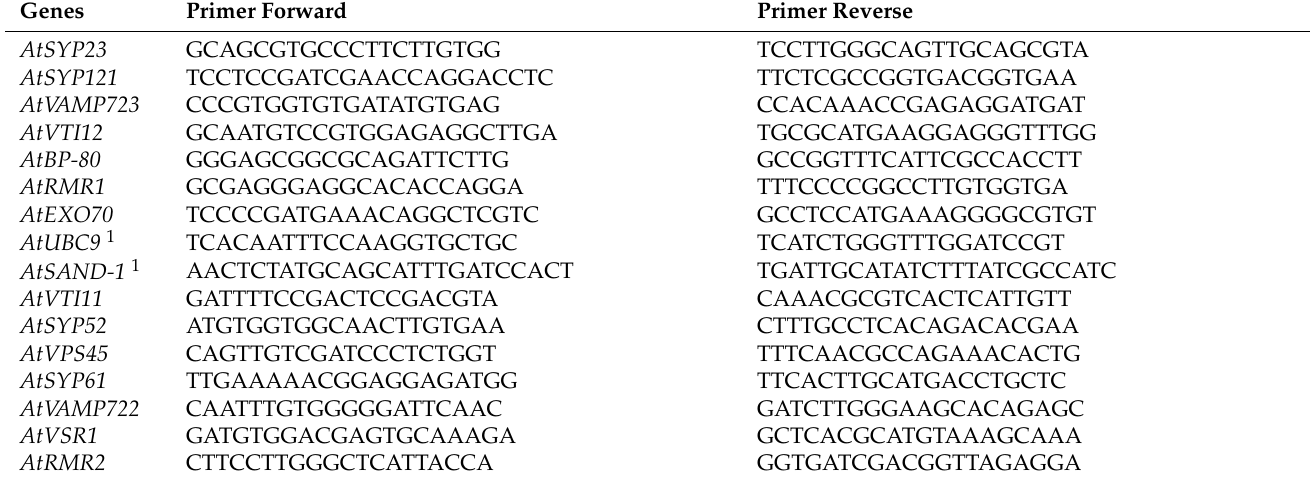
denaturation (95 ◦ C for 3 min), followed by 40 cycles of amplification and quantification (95 ◦ C for 10 s, 56 ◦ C for 10 s and 72 ◦ C for 30 s with a single fluorescence measurement) and melting curve generation (65 ◦ C to 95 ◦ C with one fluorescence read every 0.5 ◦ C). Calculation of cycle threshold (Ct), primer efficiency and expression tests were performed using Bio-Rad CFX Maestro (version 1.0) software. The analysis of the results obtained was carried out by comparison with the control condition. The housekeeping genes SAND-1 and UBC9 were used as reference genes, based on the study of Czechowski and collaborators [58]. The gene clustering by average linkage and heat map was obtained using the online software Heatmapper (http://www.heatmapper.ca/, accessed on 3 August 2021), applying the Pearson correlation between the normalized expression of the different genes and the stress conditions [59]. Table 3. List of genes and corresponding primer pairs used in the quantitative RT-PCR